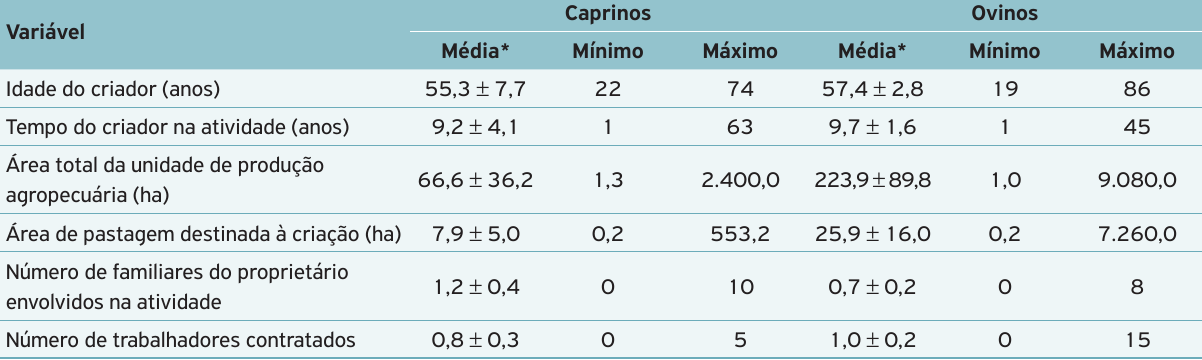
Tabela 3. Caprinocultura e ovinocultura: variáveis quantitativas, estado de São Paulo, 2010/2011.